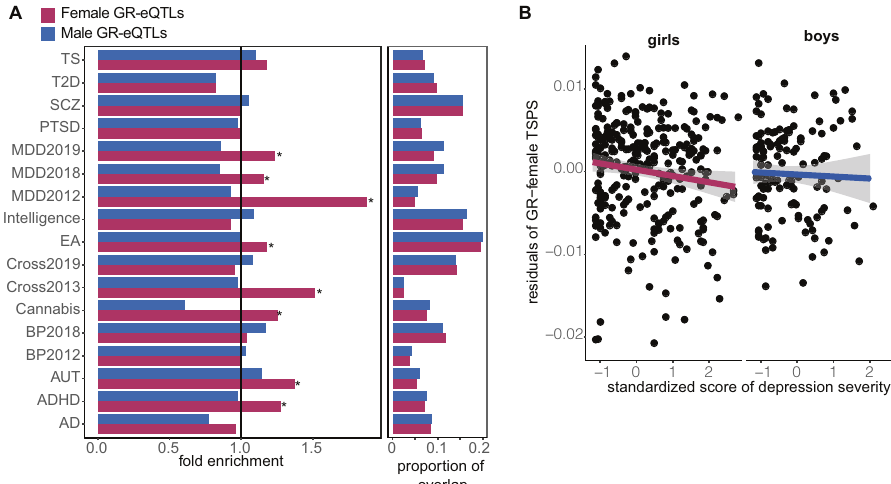
Fig. 6 Sex-strati fi ed GR-response eSNP associations with psychiatric disorders. A Bar plot of enrichment results for GR-response tag eSNPs and GWAS SNPs. The black indicates a fold enrichment at 1 and a star indicates a permutation-based FDR < 0.05. AD = Alzheimer ’ s disease, ADHD = attention-de fi cit/hyperactivity disorder, AUT = autism spectrum disorders, BP = bipolar disorder, Cross = cross disorder analysis, EA = educational attainment, MDD = major depressive disorder, PTSD = post-traumatic stress disorder, SCZ = schizophrenia, T2D = diabetes type 2, TS = Tourette syndrome. B Association between residualized female TSPSs and standardized scores of severity of depressive symptoms computed in LMU cohort (girls: β = − 7.98 × 10 − 4 , SE = 4.04 × 10 − 4 , p- value = 0.0496; boys: β = 1.12 × 10 − 3 , SE = 8 .3 × 10 − 4 , p- value =